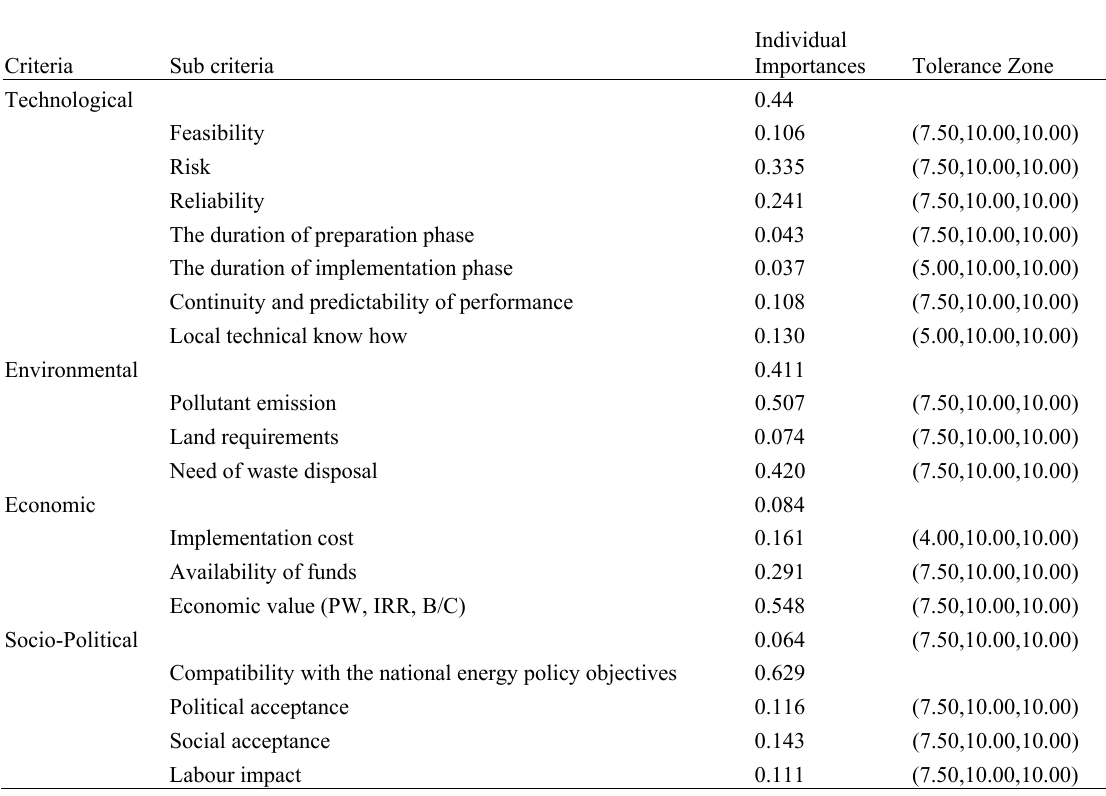
Table 3. Individual importances of criteria and the tolerance intervals